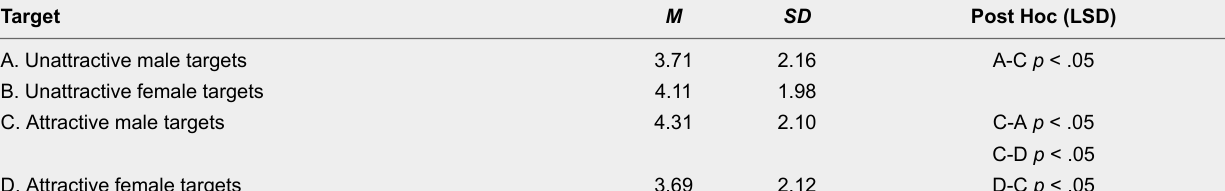
Perceived Openness: Simple-Effects Comparisons for the Interaction of Attractiveness and Target Gender.